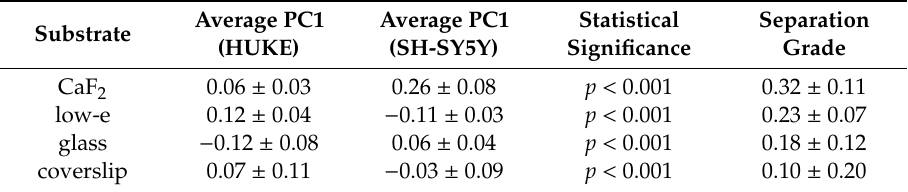
Figure 2. PCA score plot for the 2750–3000 cm − 1 spectral range for HUKE (red circles) and SH-SY5Y (black circles) cells grown on CaF 2 ( a ), low-e ( b ), glass ( c ), and coverslip ( d ) substrates. Table 1. Average values of PC1 for HUKE (second column) and SH-SY5Y (third column) cells grown on di ff erent substrates (first column). Statistical significance of separation of PC1 values for the two types of cells is reported in the fourth column, whereas the fifth column shows the di ff erence of average PC1 values.